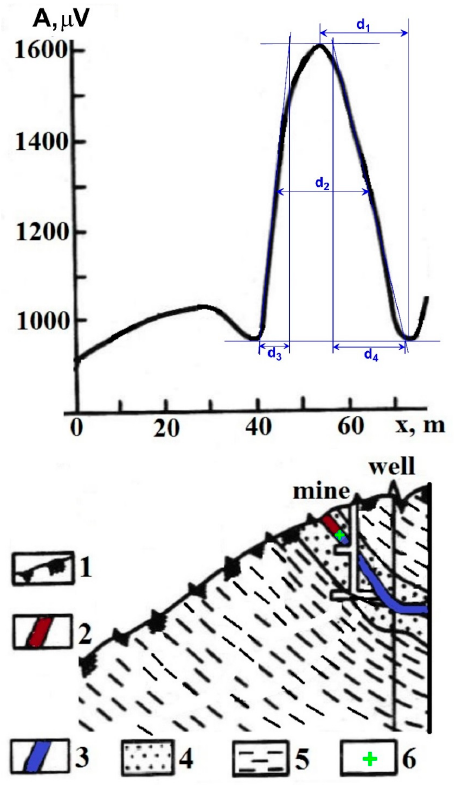
Figure 4. Quantitative examination of piezoelectric anomaly observed at one of gold-quartz deposits of Yakutia region (Russia) (initial geological-geophysical data from [30]: (1) soil-vegetation layer; (2) oxidized upper part of quartz vein; (3) quartz vein; (4) sandstone; (5) siltstone; and (6) determined position of the center of upper edge of anomalous body.